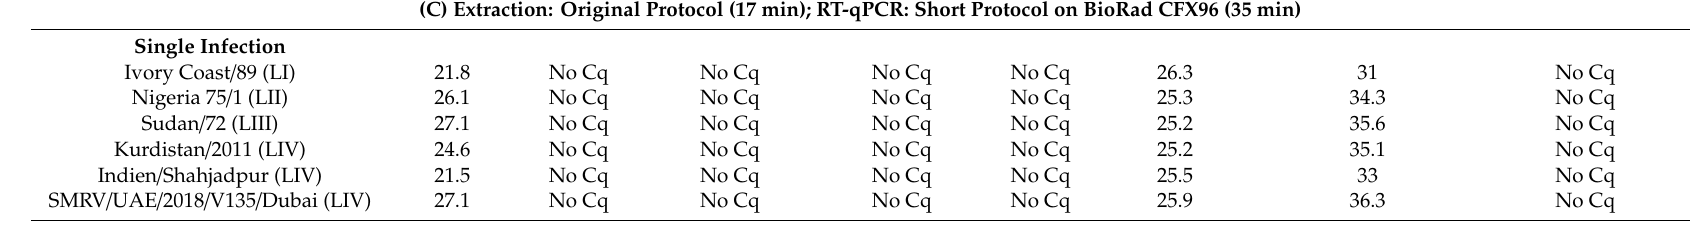
(D) Extraction: Short Protocol (7 min); RT-qPCR: Short Protocol on BioRad CFX96 (35 min)